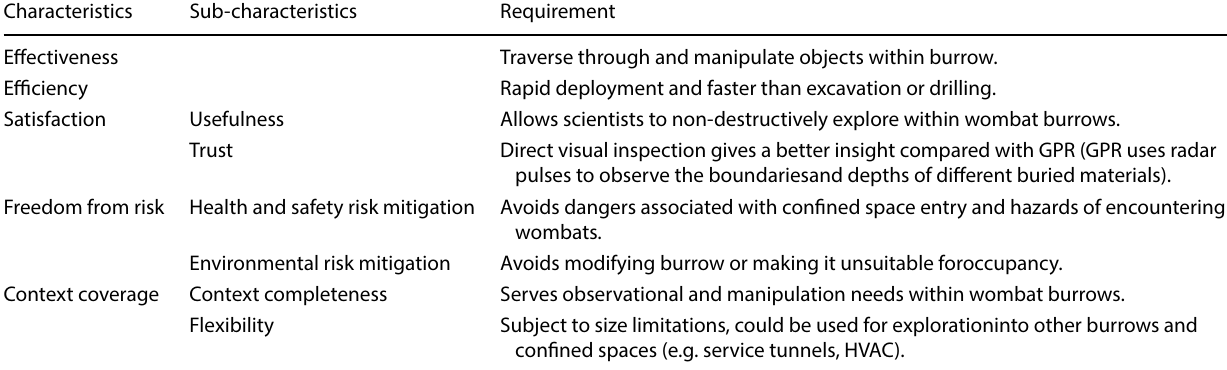
Fig. 1 Wombat robot alongside a model wombat for comparison Table 1 Analysis of quality in use